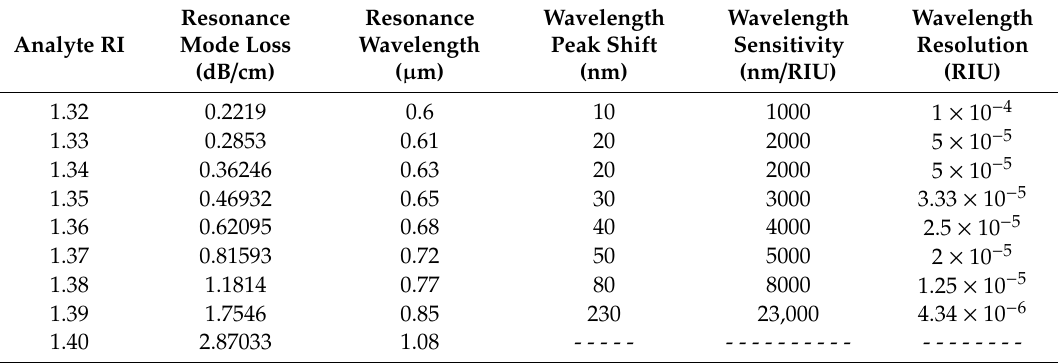
Table 1. Performance investigation for the analyte RI detection range from 1.32 to